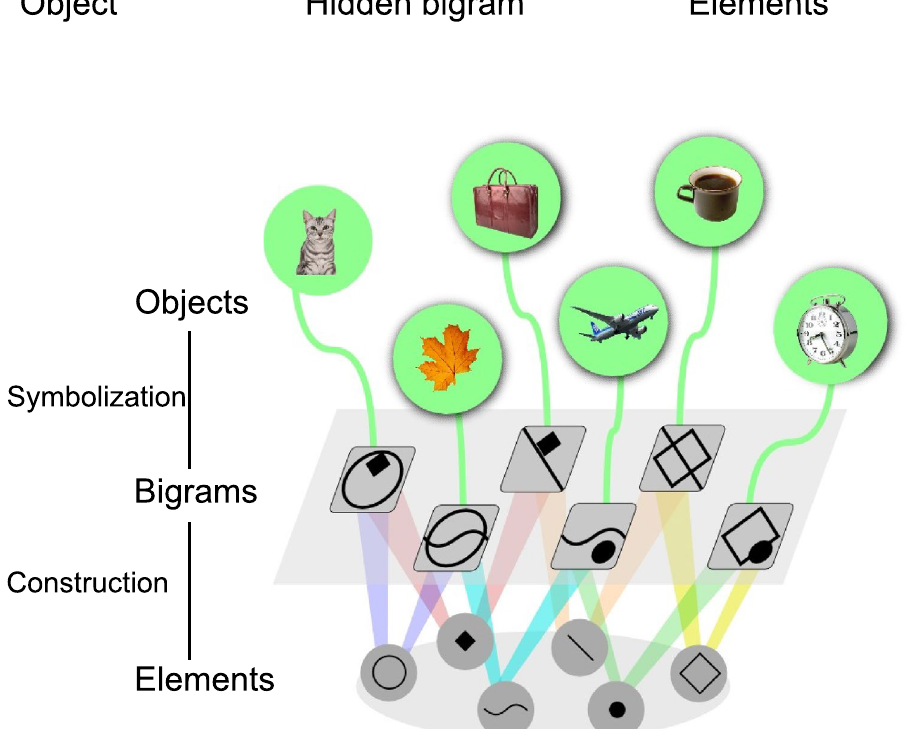
Figure 1. Design of a dual-structured visual symbol system. ( a ) Dual structure of written English (top) and Yerkish (bottom). An English word (e.g., “CAT”) serves a meaningful linguistic unit representing an object (a four-legged animal) and, concurrently, is a combination of meaningless letters (e.g., “C”, “A” and “T”). Similarly, a Yerkish bigram serves as a meaningful unit representing an object and is a combination of two meaningless elements. ( b ) A test paradigm examining the ability of monkeys to mentally construct dual-structured symbols. After object-bigram symbolization learning and visually guided bigram construction learning, we examined whether the monkeys could sequentially choose the elements constituting the bigram symbolically associated with an object, even when the bigram symbol itself is hidden. ( c ) Dual-structured visual symbol system. Six objects (upper) are represented by six arbitrary Yerkish bigrams (middle), which comprise different combinations of elements